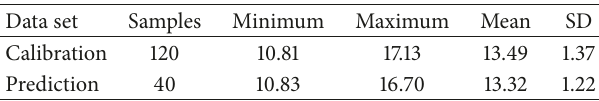
Table 1: Statistic values of SSC ( ∘ Brix) for the calibration and prediction sets of